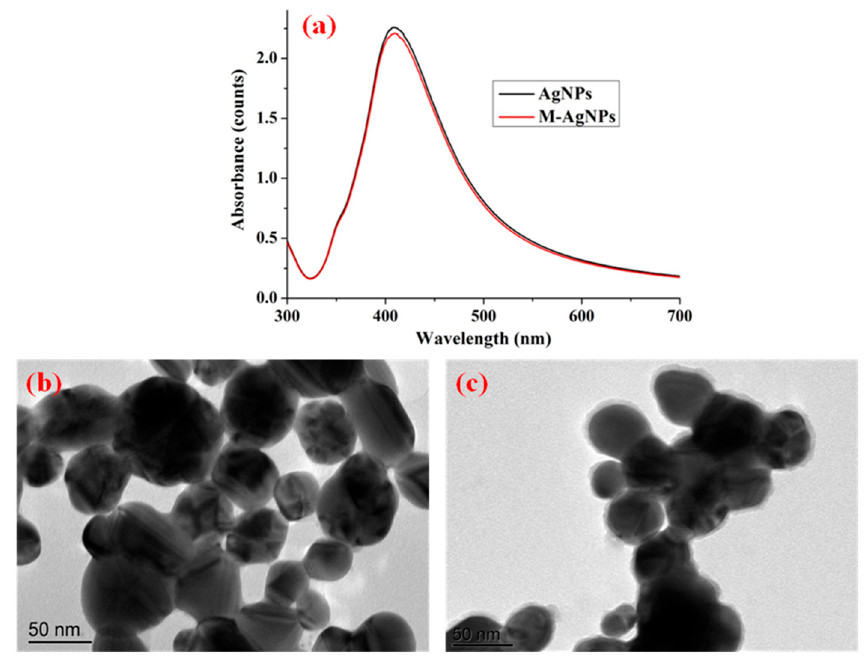
Figure 1. UV-vis spectra of AgNPs and M-AgNPs ( a ), TEM images of ( b ) AgNPs and ( c ) M-AgNPs3.2. SERS activity of different modified substrates.